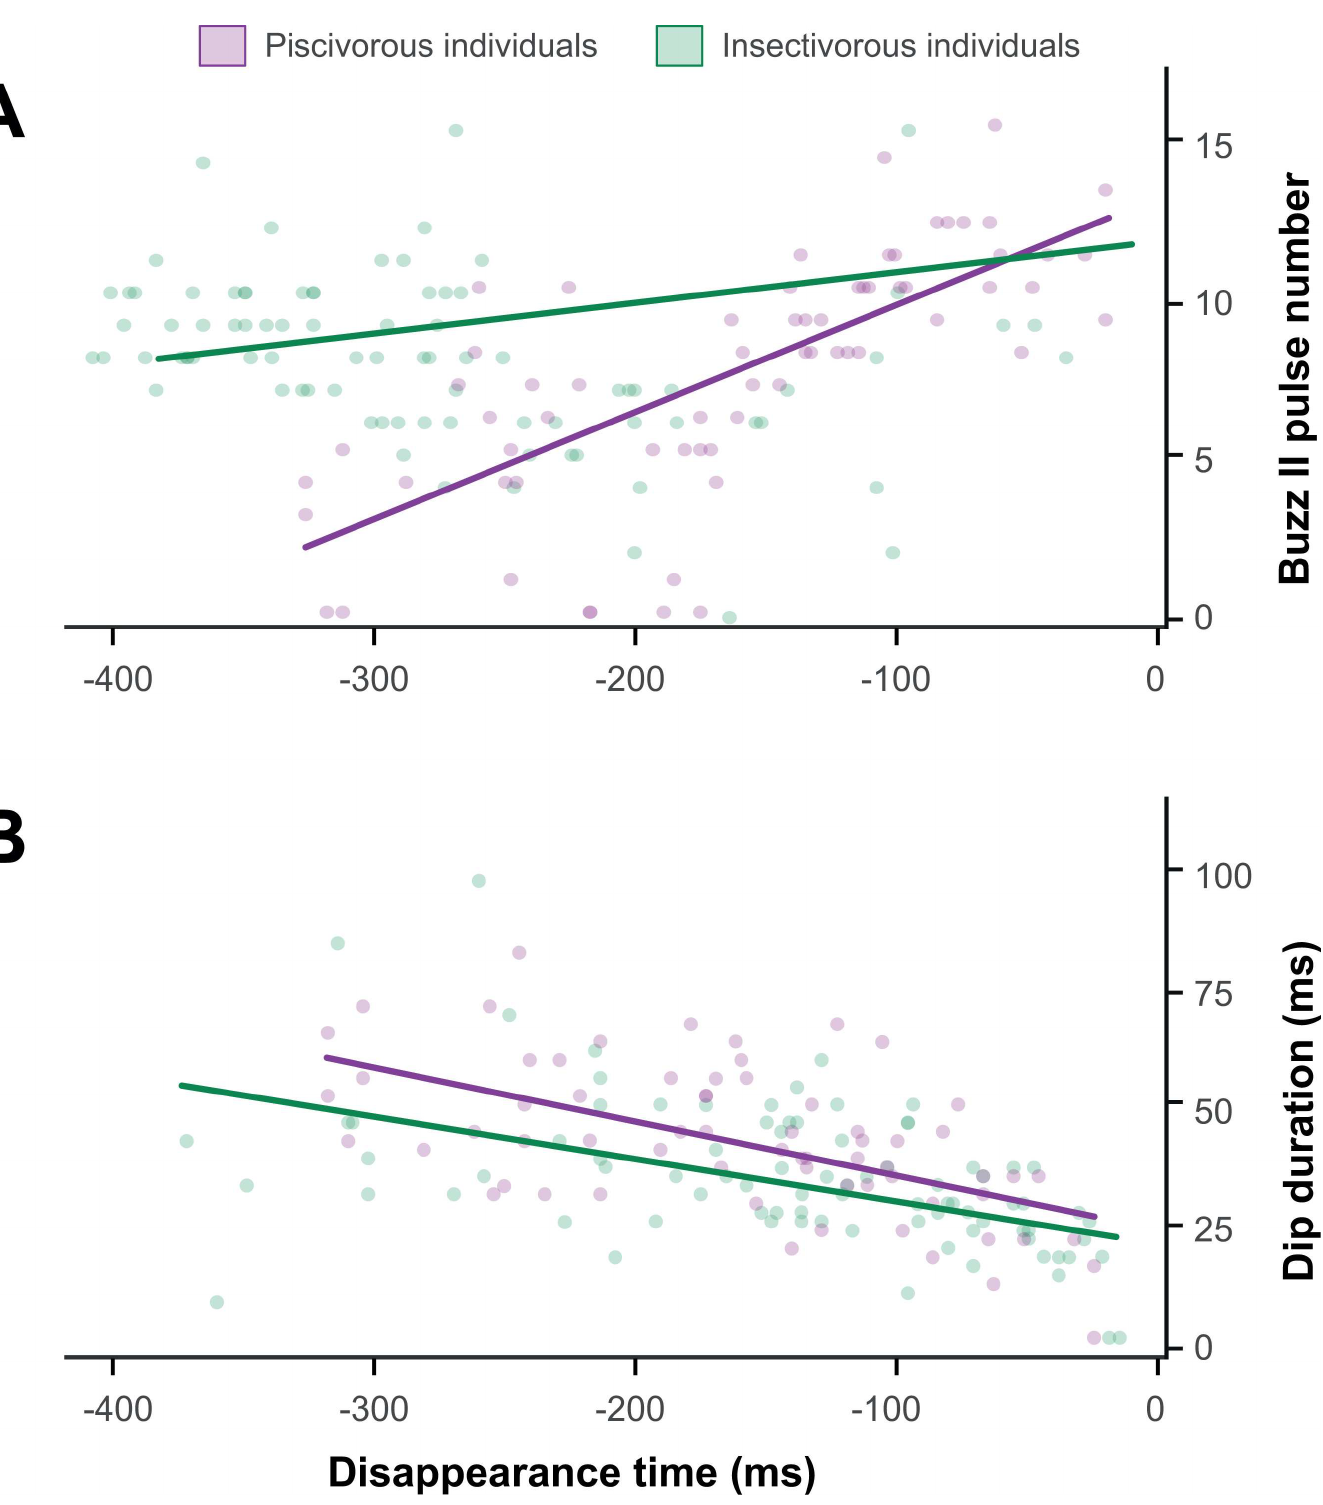
PLOS ONE | DOI:10.1371/journal.pone.0167164 December14,